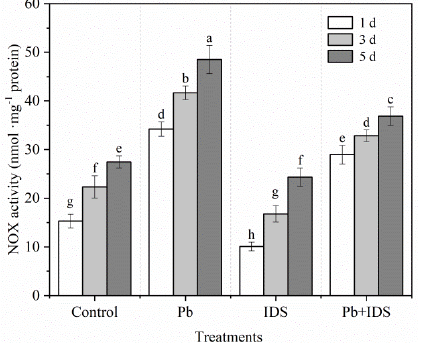
Figure 8. Effects of Pb, IDS, and Pb+IDS on NOX activities of maize seeds. Maize seeds incubated with distilled water (control), Pb (20 mmol·dm −3 PbCl 2 ), IDS (100 mmol·dm −3 ), or Pb+IDS were used, and NOX activities were measured 1, 3, and 5 d after sowing. Error bars represent the standard deviation of the mean ( n = 5). Means associated with different letters are significantly different among treatments and time points ( p < 0.05; Duncan’s new multiple range test). Pb, lead; IDS, iminodisuccinic acid; NOX, NADPH oxidase.